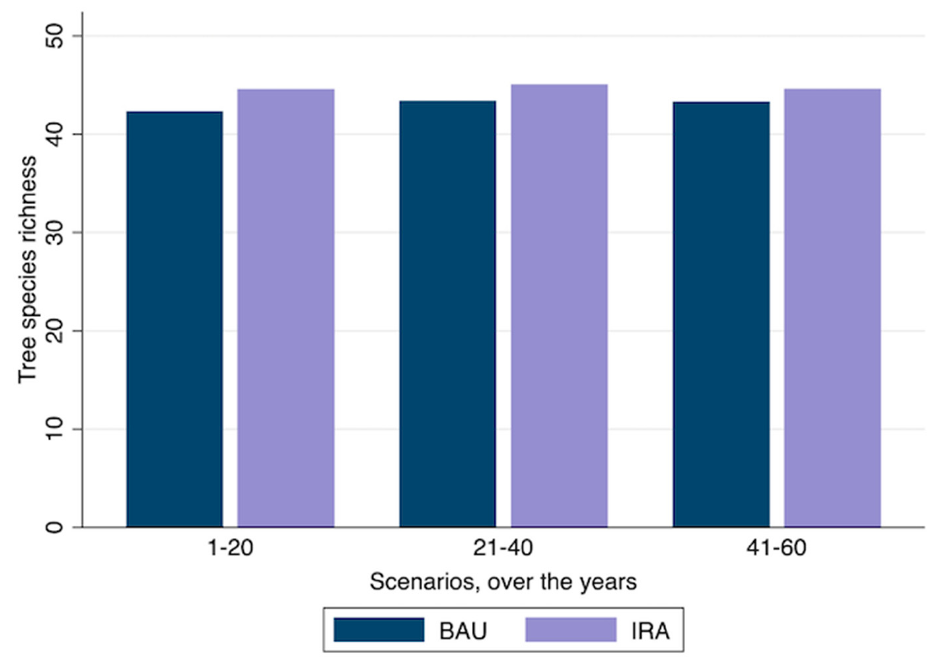
Figure A2. Simulation results: tree species richness over time.